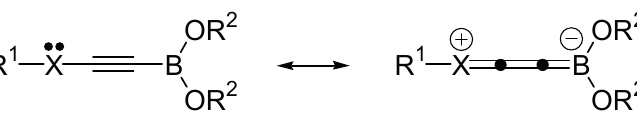
Figure 1. Heteroatom-substituted alkynylboronates.